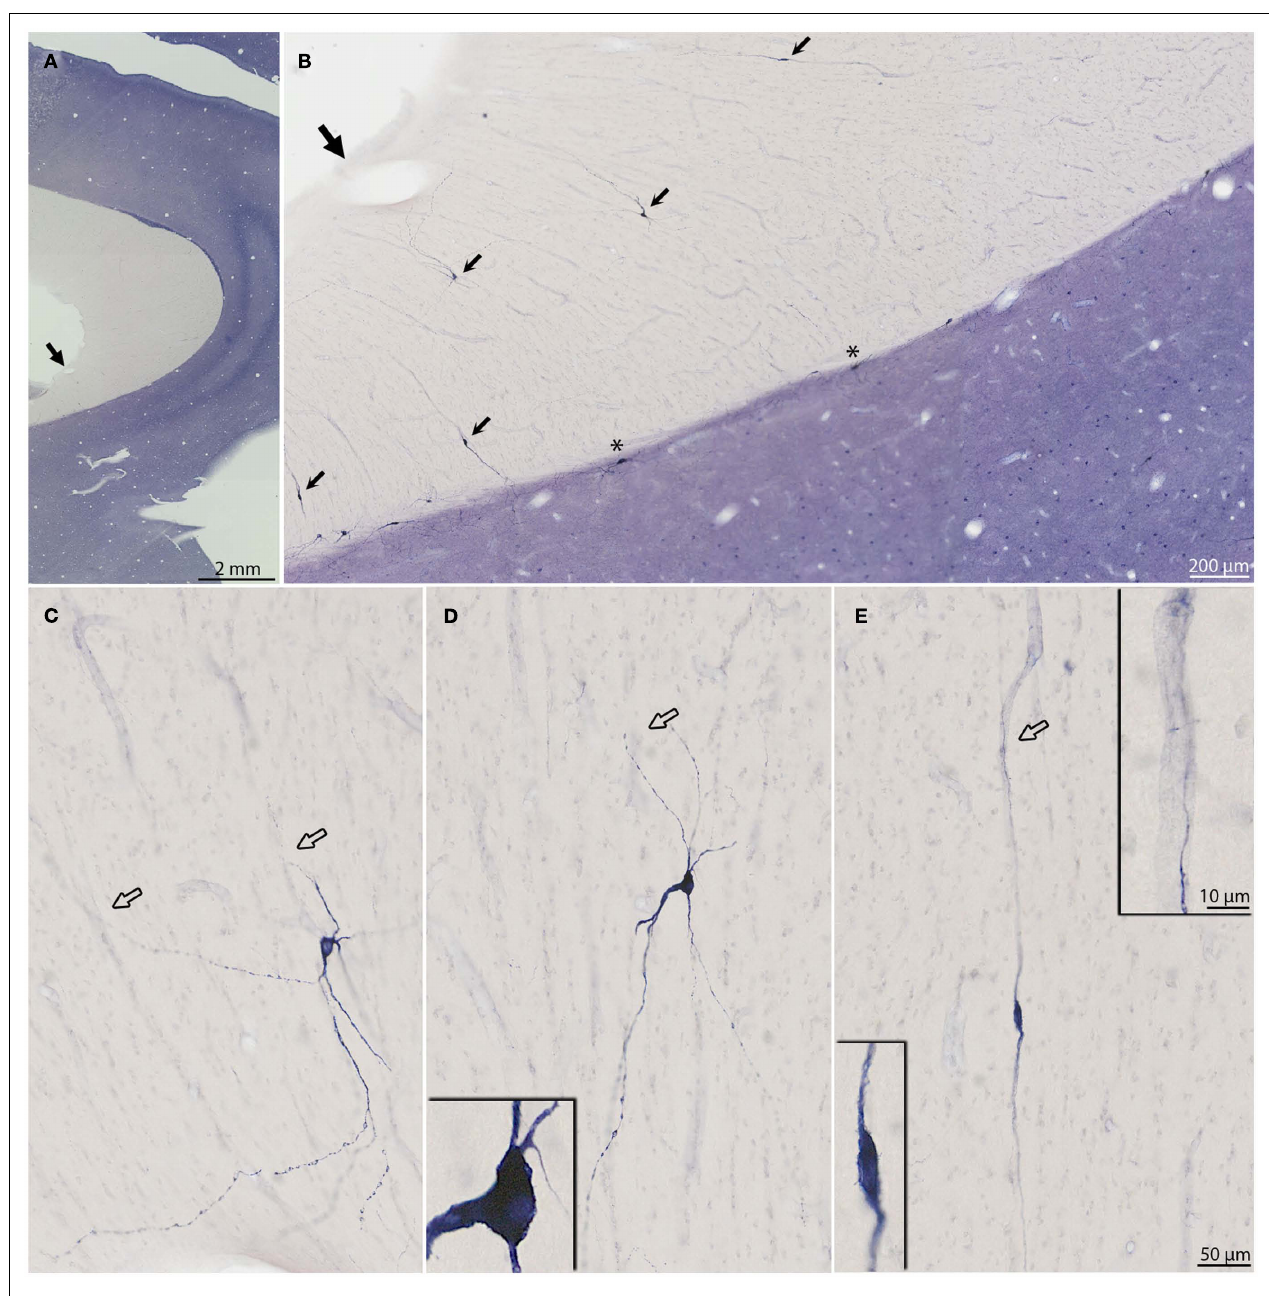
with one very thick dendrite. Inset in [ (E) at lower left] is an example of a neuron with thin soma and bipolar dendritic arborization. Inset in [ (E) at upper right] shows close association of dendrite and blood vessel. Individual neurons have been rotated so that they are approximately perpendicular to the dorsal surface of the brain. Hollow arrows indicate points where NADPHd + dendrites are in close proximity to blood